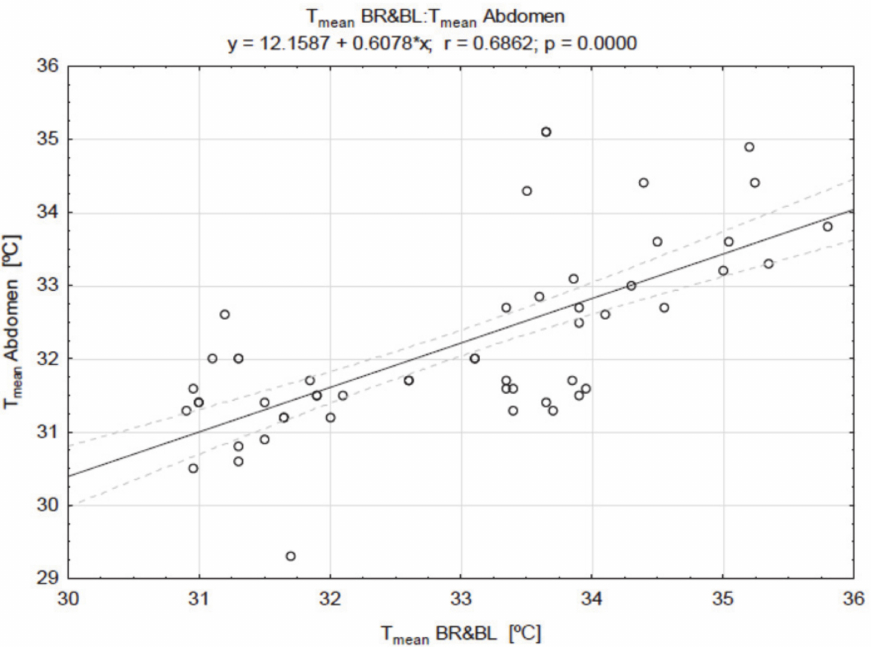
Figure 4. The result of the correlation between the values of breast (BR & BL) and abdomen tempera- tures (T mean